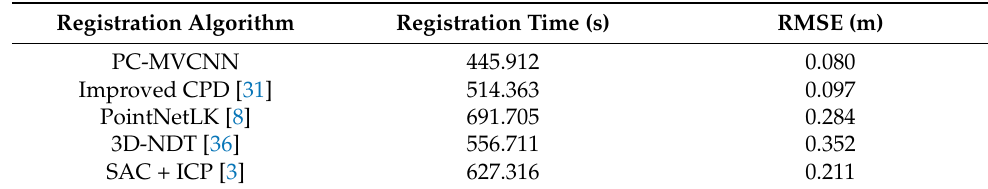
Table 5. Registration results of various algorithms for Tangna karst cave point cloud data in Bamei Town, Yunnan Province. Figure 9. Local details of point cloud registration of Tangna karst cave, Bamei Town, Yunnan Province. ( a ) PC-MVCNN; ( b ) Improved CPD; ( c ) PointNetLK; ( d ) 3D-NDT; ( e ) SAC + ICP.